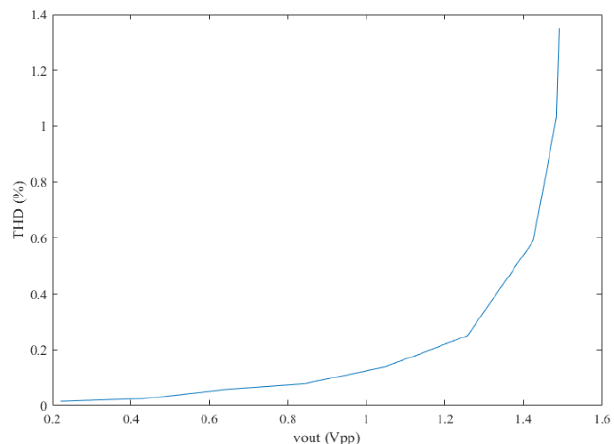
Figure 14. The THD of the AFE with different peak-to-peak outputs (when the input photocurrent is Figure 14 . The THD of the AFE with different peak ‐ to ‐ peak outputs (when the input photocurrent is 1.12 µ A and the signal is a 1-Hz sine wave with a small amplitude). 1.12 μ A and the signal is a 1 ‐ Hz sine wave with a small amplitude).